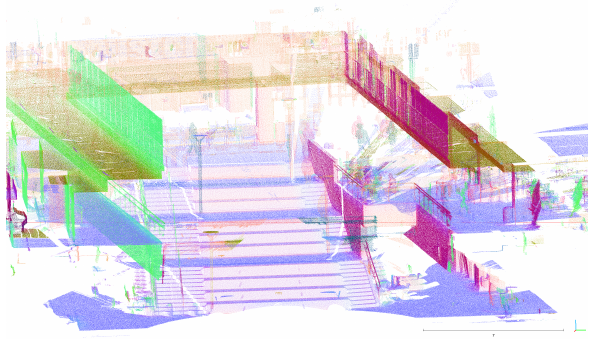
Figure 5. Riegl VZ-2000 Point Cloud of Student Center, False HSV Colored by Planar Surface Normal